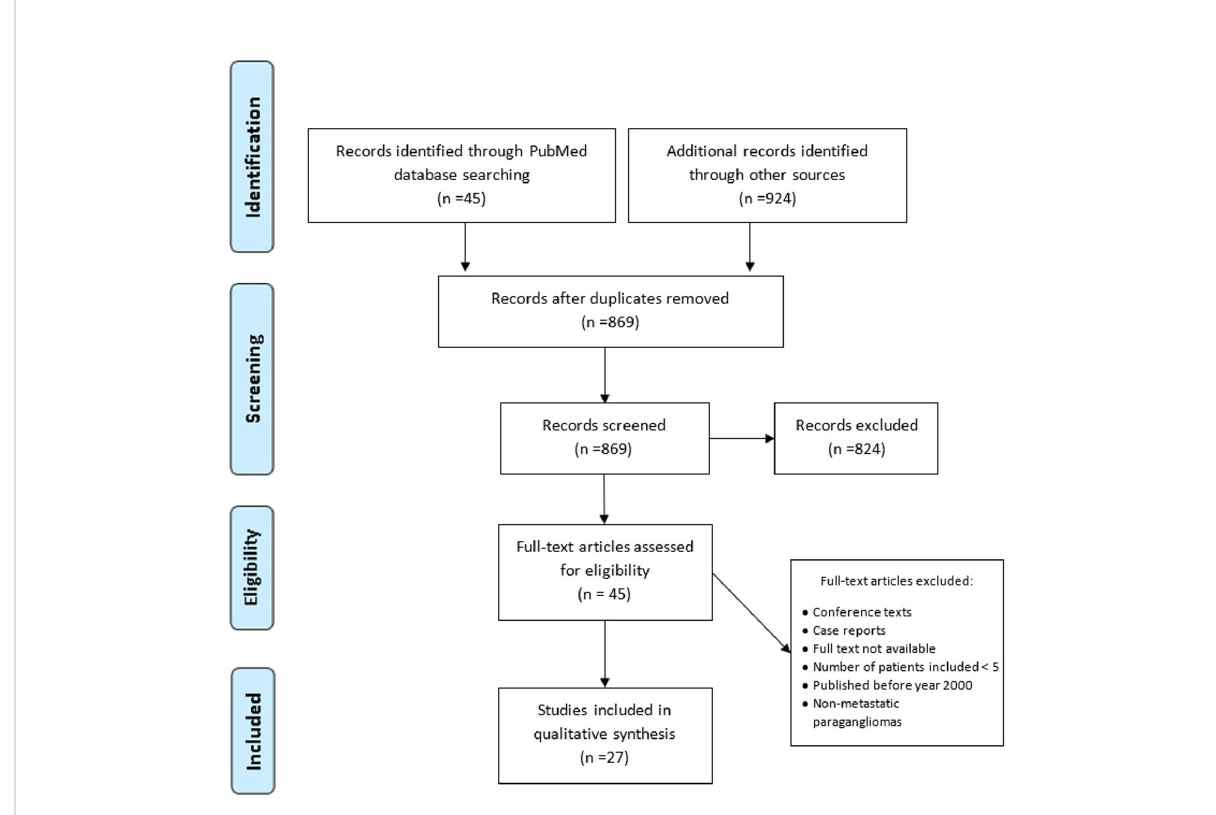
FIGURE 1 Flow chart of the search strategy and inclusion/exclusion